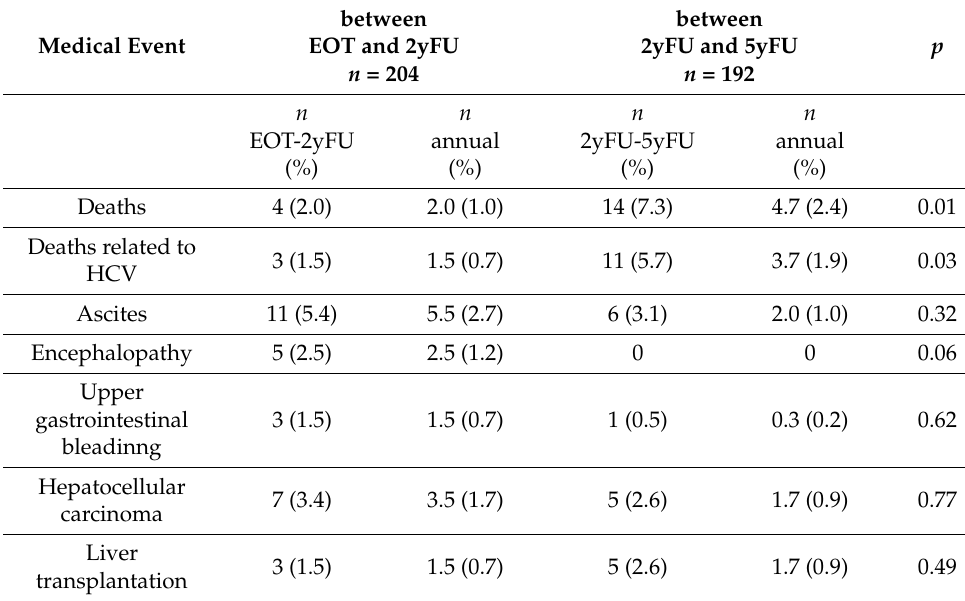
Table 2. Medical events observed during 5 years of follow-up. Comparison of annual prevalence of events in the initial 2 years and following 3 years of follow-up. Fischer exact